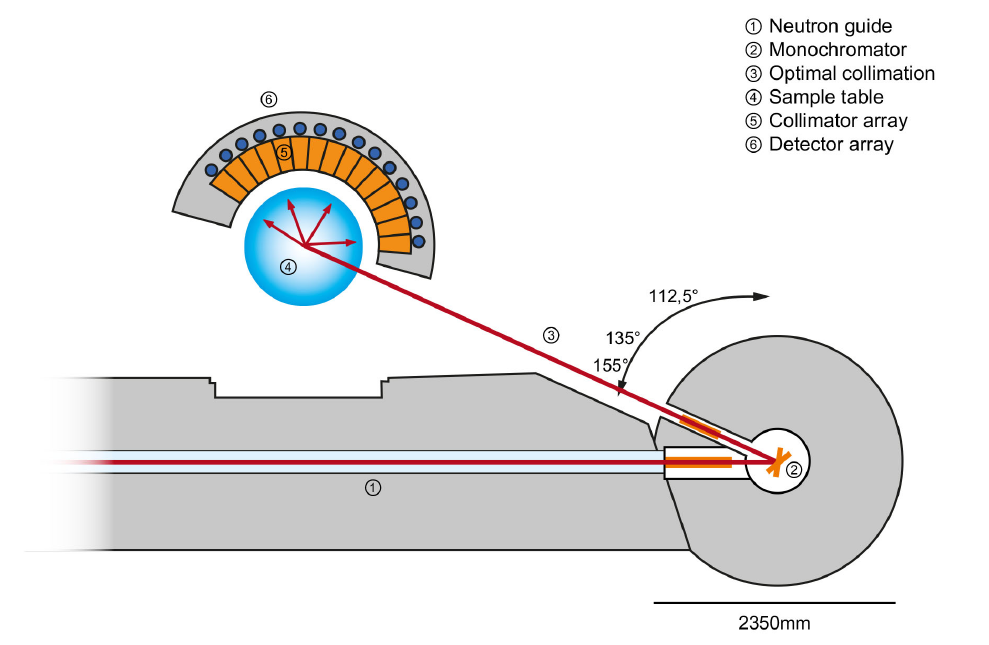
Figure 2: Schematic drawing of